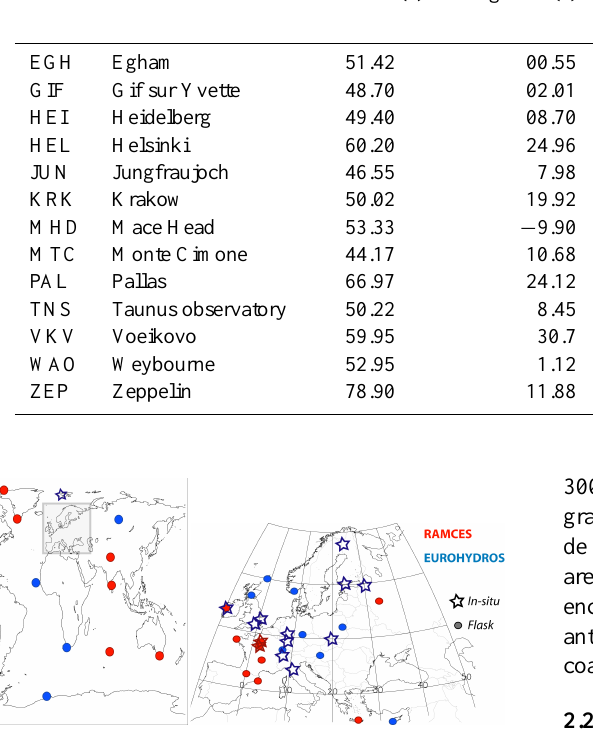
Fig. 1. EUROHYDROS and RAMCES sampling sites used in this study